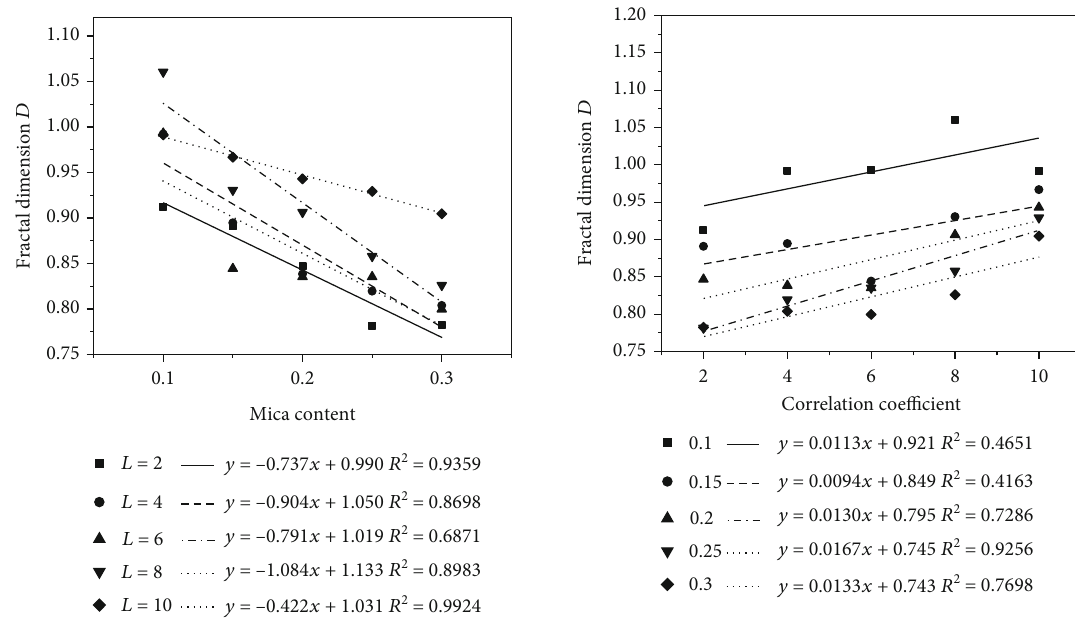
Figure 10: Fractal relationship between di ff erent mineral fabrics and specimen